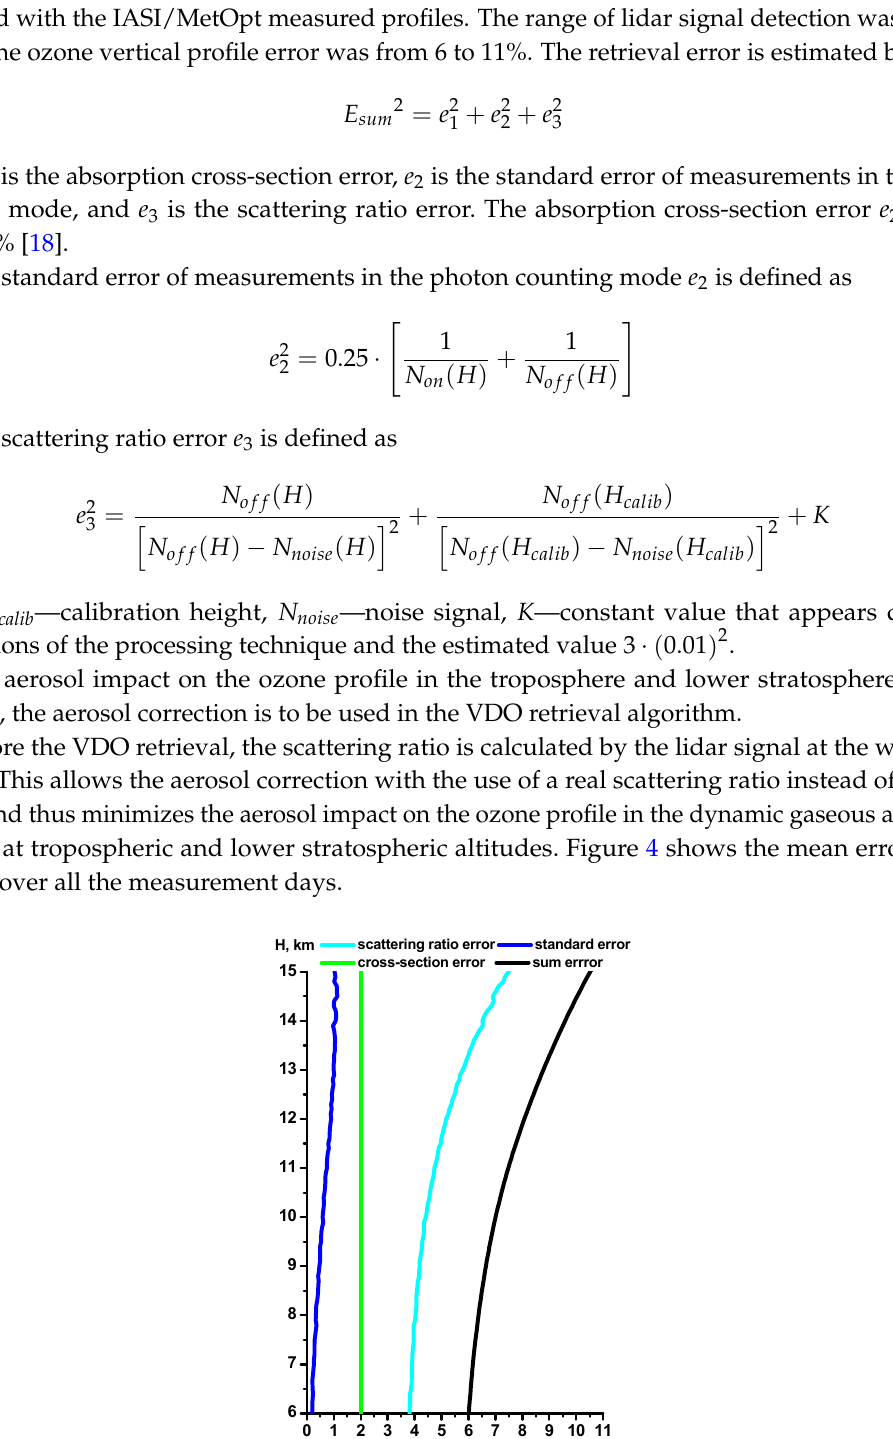
( b ) Figure 5. VDO profiles retrieved in comparison with the Kruger model: ozone profile without temperature and aerosol corrections (1), ozone profile with temperature and without aerosol corrections (2), ozone profile without temperature and with aerosol corrections (3), combination of corrections (aerosol and temperature) (4) ( a ); VDO profiles retrieved in comparison with the Kruger model and IASI satellite data ( b ). We have analyzed the ozone profiles retrieved for April 2015 corrected to the temperature and aerosol and without corrections. One can see from Figure 5a that the efficiency of the corrections is significant. For the retrieval without temperature correction, the absorption cross-section constant σ 299 = 4.4 × 10 − 19 cm 2 was used. High saturation of the aerosol component at tropospheric and lower stratospheric altitudes is corrected to both aerosol (terms C and D or Equations (12) and (15)) and temperature (term A or Equation (8)). Each correction used approaches the profiles to the IASI data.